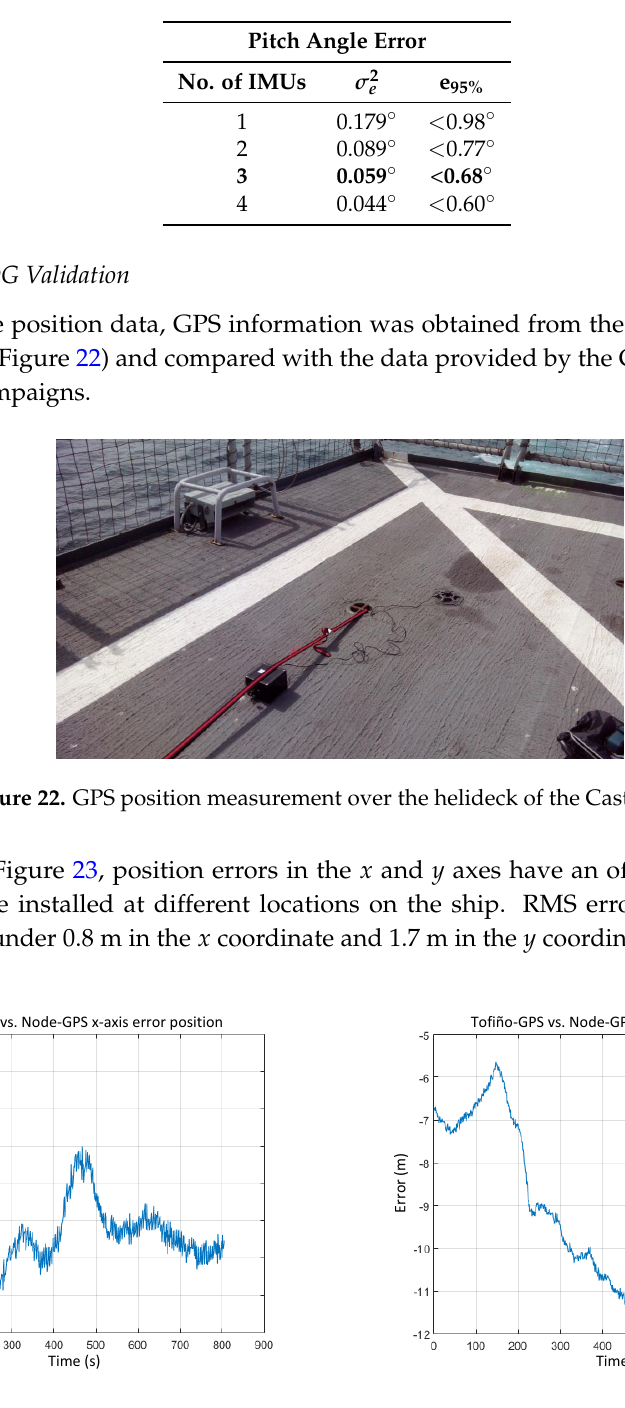
Table 4. Pitch angle error improvement obtained from multiple inertial sensors.